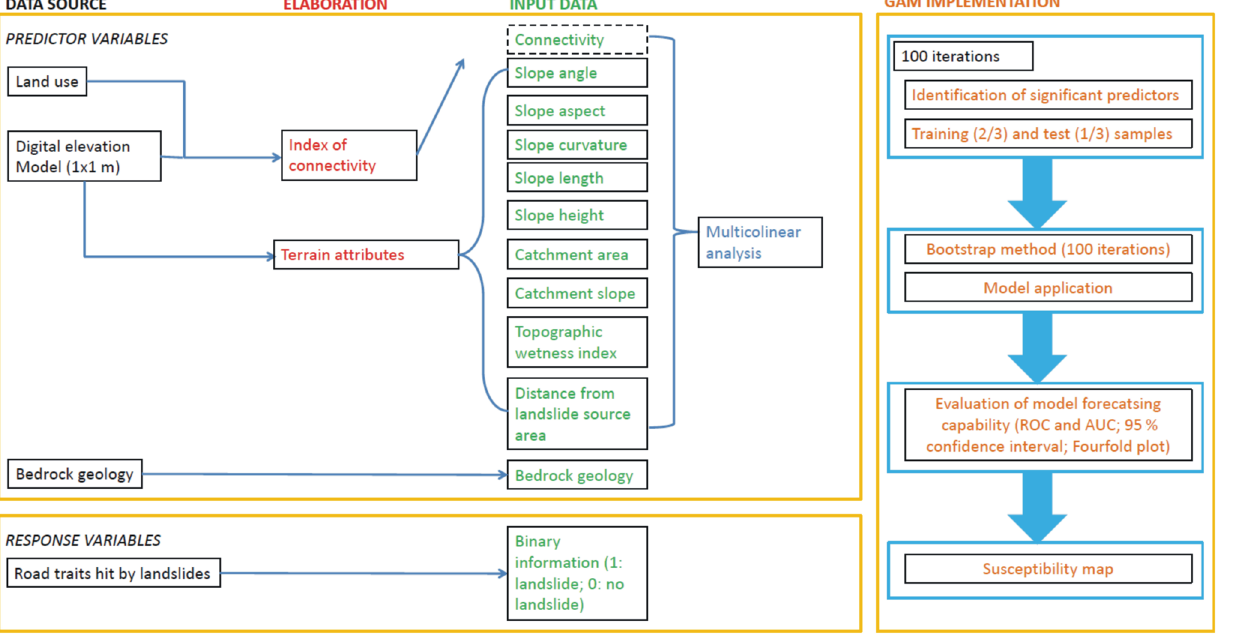
Figure 4. Flow-chart containing the scheme for the implementation of the proposed